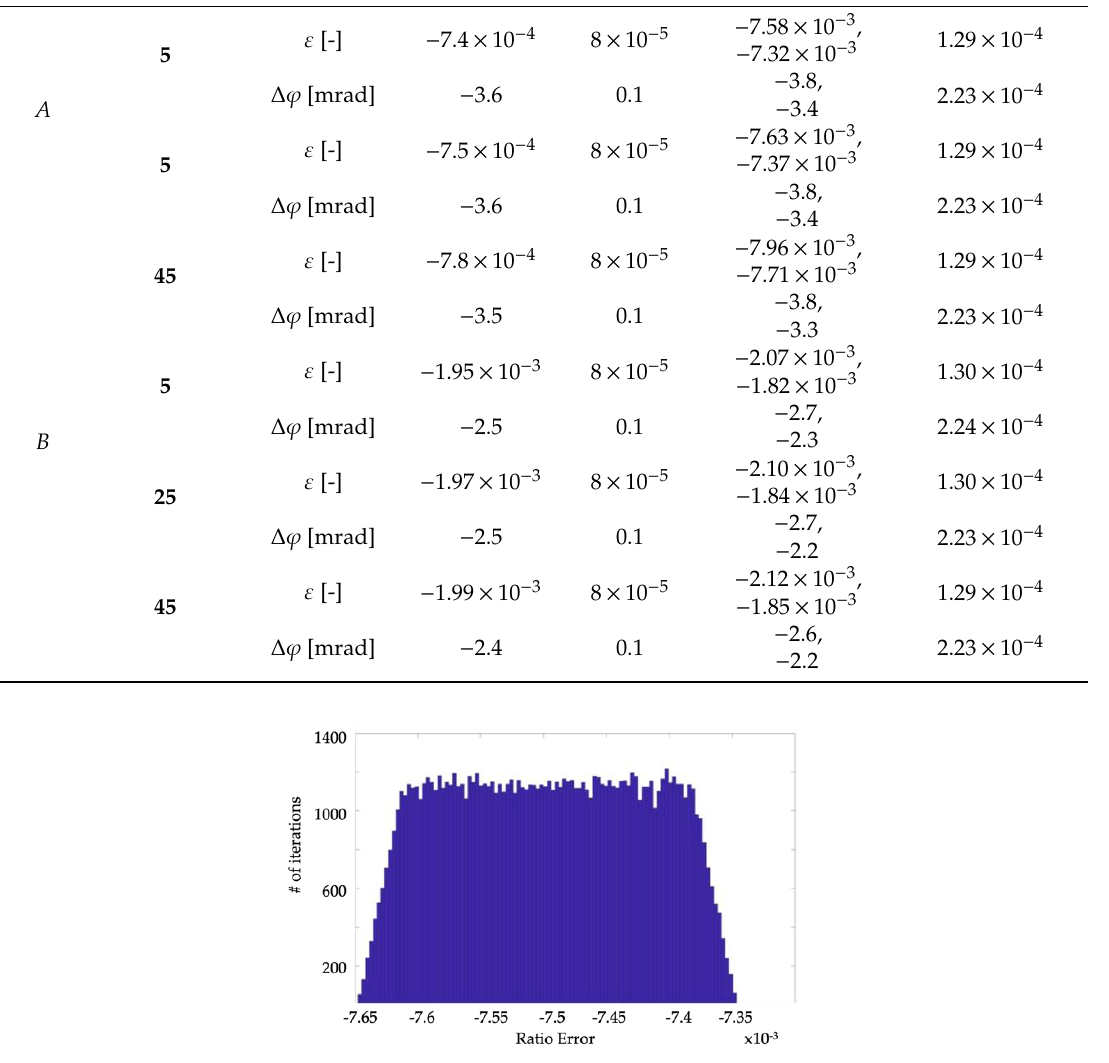
Figure 6. PDF of the ε calculated from the metrological characterization of the items.